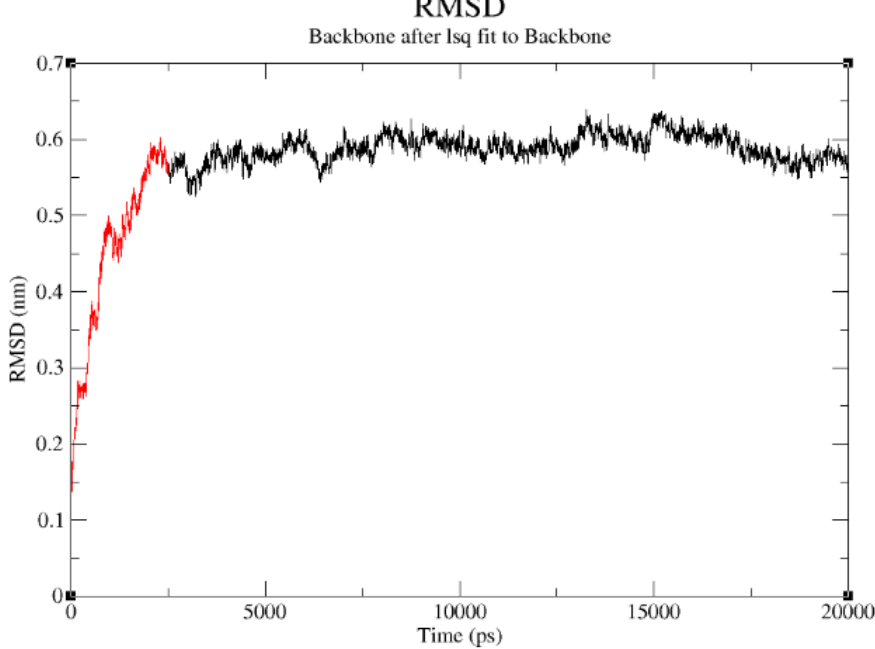
Figure 5. RMSD of DehD stable conformation observed after the extension of a simulation run from 5000 ps to 20,000 ps. Extension from 5000 ps to 20,000 ps shown in black color.